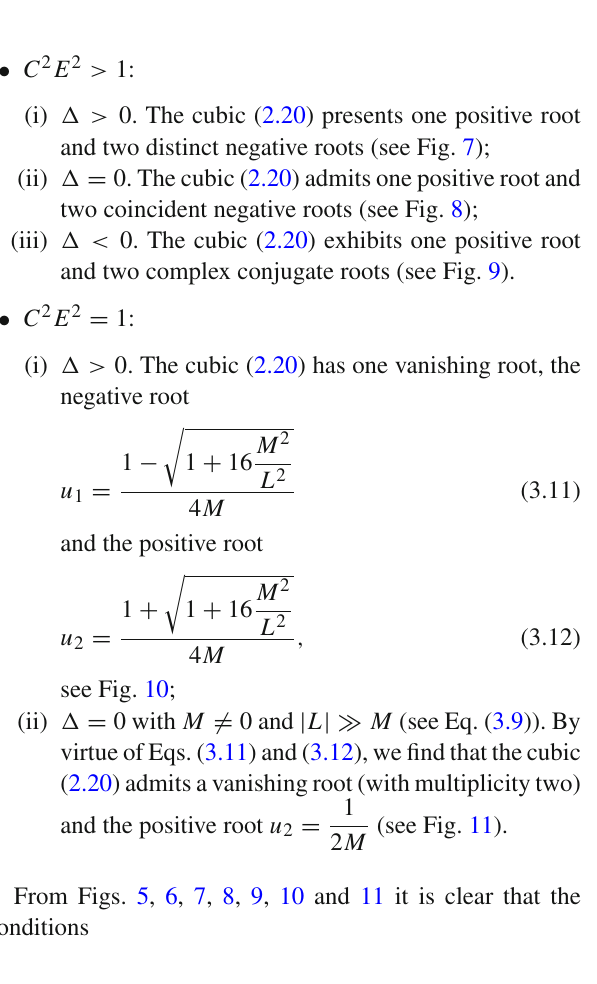
Fig. 6 The positive roots of Eq. (2.20) when C 2 E 2 < 1 and (cid:9) = 0